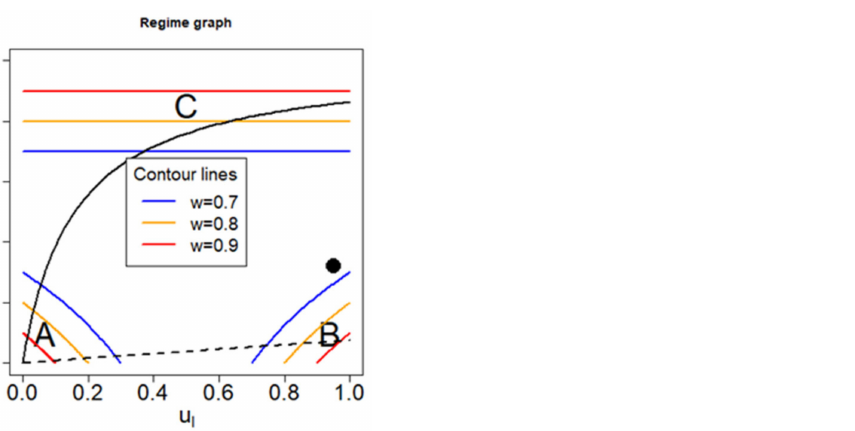
Figure 3. General regime graph depicting the position of the A) quick release, B) near equilibrium, and C) ventilation driven regime. Some contour lines for the weights of each regime are depicted. The black fat point at the right indicates a specified (arbitrary) scenario. The black curves show all possible positions in the regime graph for two respective scenarios from the ConsExpo paint products factsheet: the solid curve presents the line for the brush- and roller-painting–two-component paints– mixing and loading, while the dashed curve shows the line for the water borne wall paint